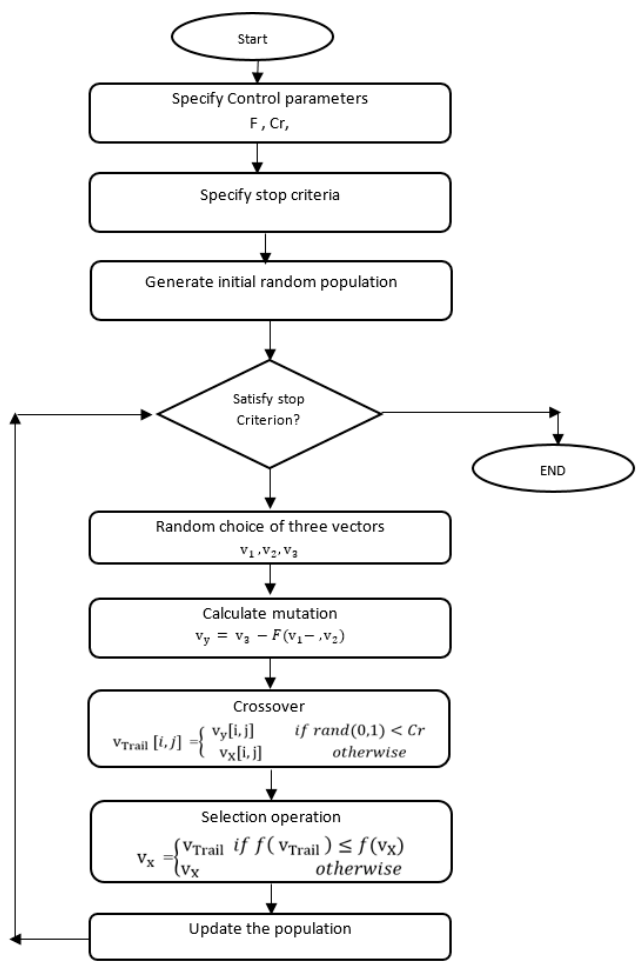
Figure 3. Pseudo-code of classic differential evolution.